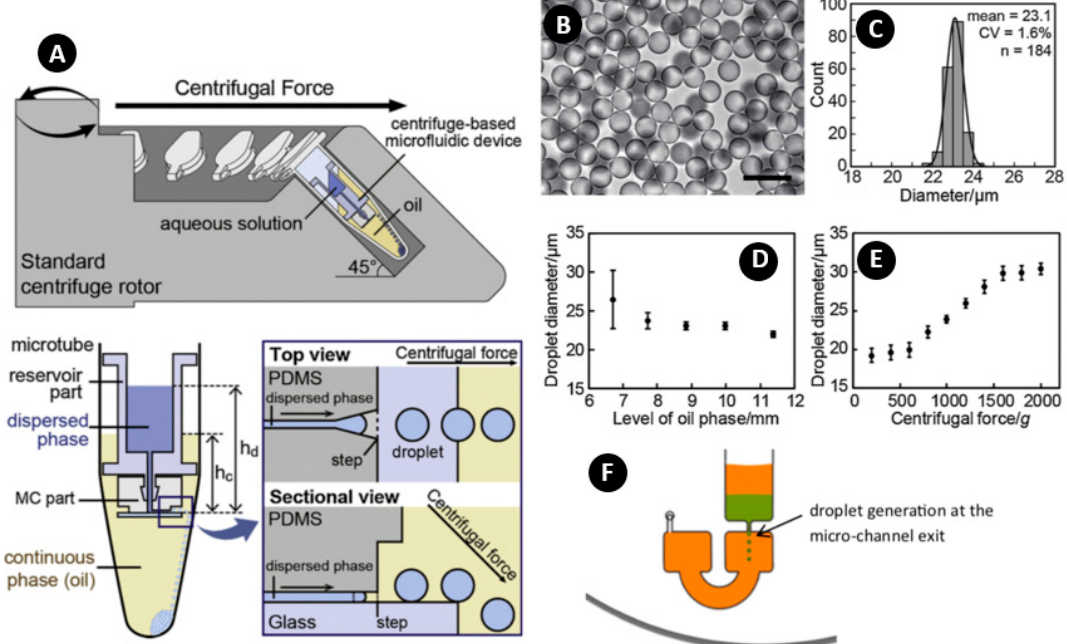
Figure 5. ( A ) Principal of step emulsification in a centrifugal system. ( B ) Microscope image of produced droplets at 1000 g (scale bar 50 µm); ( C ) Diameter distribution of the produced droplets; ( D ) Effect of the level of oil phase to droplet diameter; ( E ) Effect of centrifugal force to droplet diameter. Reprinted with permission from [73]; ( F ) Droplet generation in stationary carrier phase. Reprinted with permission from [43].